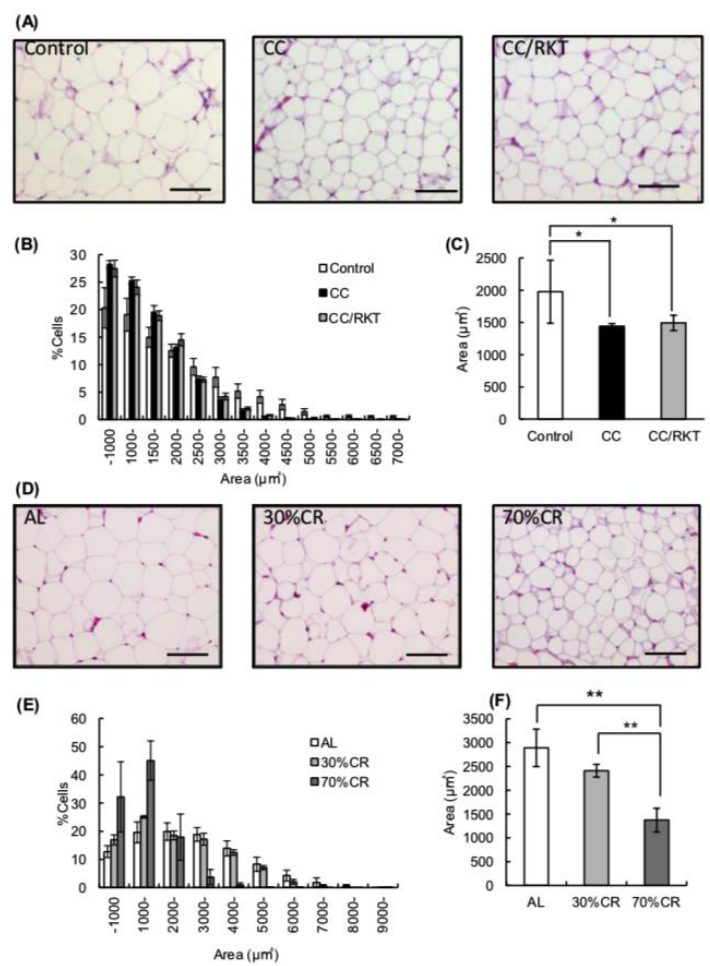
Figure 1. Effects of cancer cachexia (CC), rikkunshito (RKT) and caloric restriction (CR) on the histologic features of epididymal white adipose tissue (eWAT). Representative hematoxylin and eosin-stained histologic sections of eWAT from ( A ) control, CC, and CC/RKT rats and ( D ) rats fed ad libitum (AL) and subjected to CR (Magnification ×100, scale bar = 100 µm). Distribution of adipocyte size in ( B ) control, CC, and CC/RKT rats, and ( E ) AL and CR rats. The average of median adipocyte size in ( C ) control, CC, and CC/RKT rats, and ( F ) AL and CR rats. Error bars represent the SD associated with each mean ( n = 5 – 6); * p < 0.05, ** p < 0.01 by Tukey’s test.